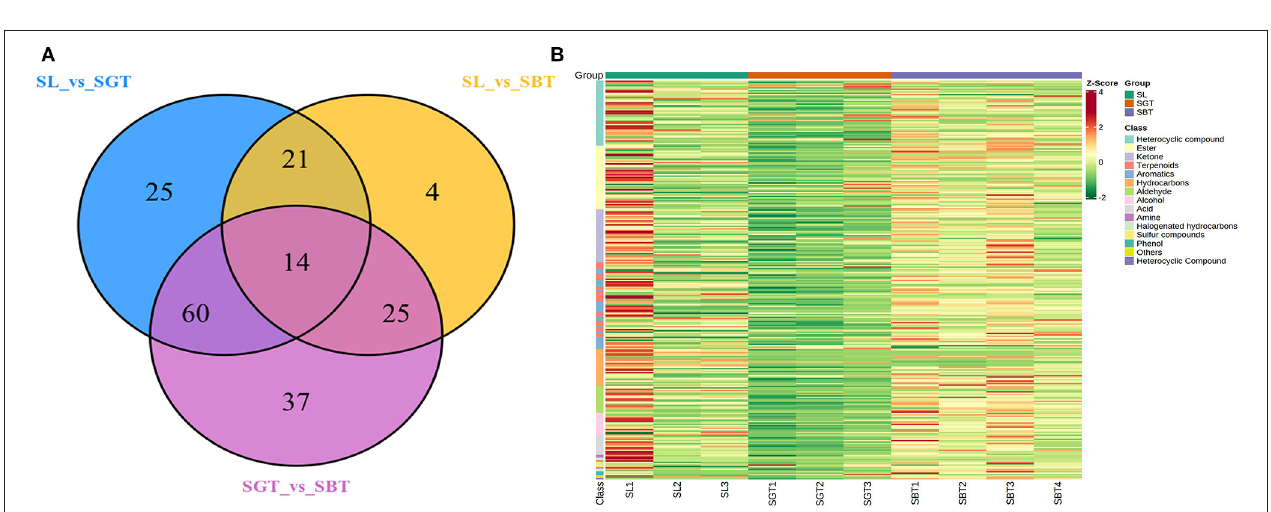
FIGURE 4 | Gas chromatography-mass spectrometry (GC-MS) analysis of SL, SGT, and SBT. (A) Venn plot. (B) Heat map.